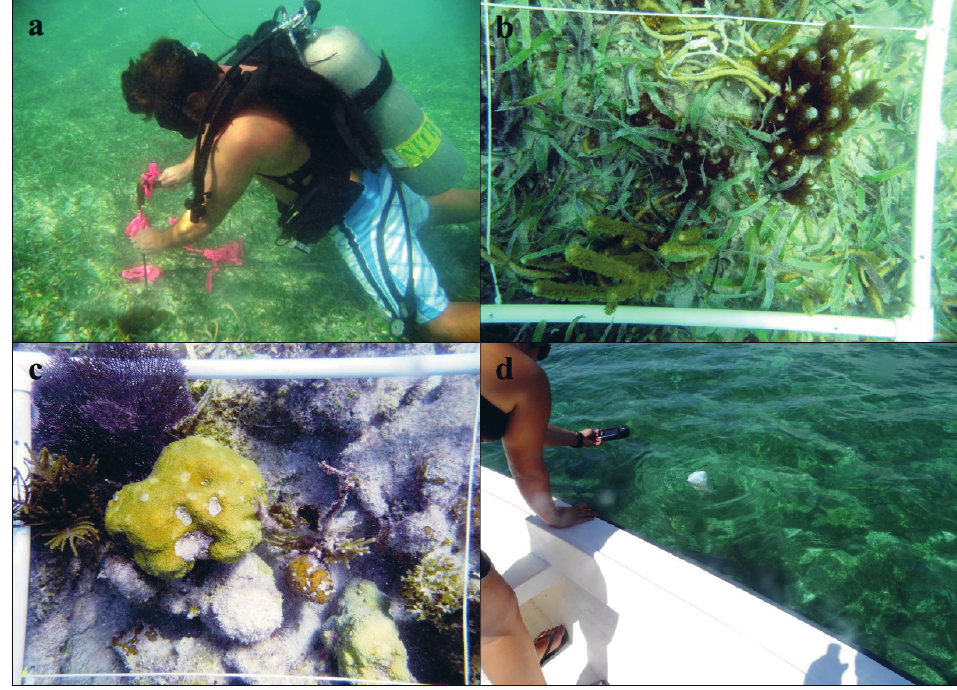
Figure 2. ( a ) Flagged rebar was hammered into non-living substrate and tightly tethered to the surface to mark the GPS location for each habitat plot; ( b ) Photoquadrat of seagrass area mixed with soft corals; ( c ) Photoquadrat of from the reef crest area showing soft corals, hard corals, encrusting sponge, algae and non-living substrate; ( d ) Recording the GPS location of a habitat plot (tethered